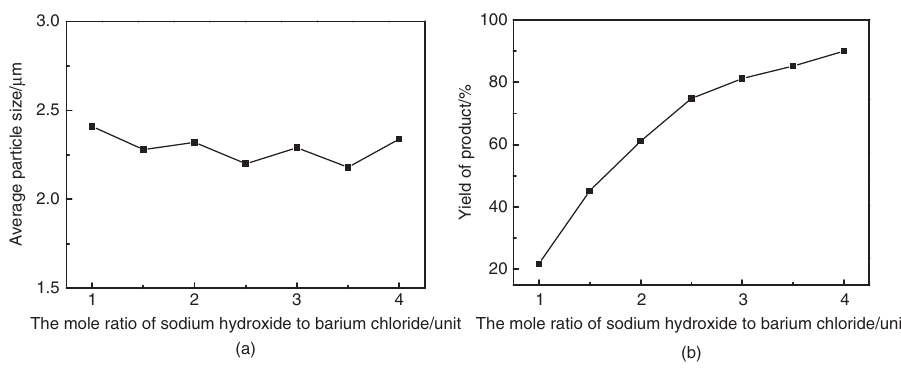
Figure 4: Effect of NaOH concentration on average particle size (a) and yield of product (b) in the microwave homogeneous precipitation,